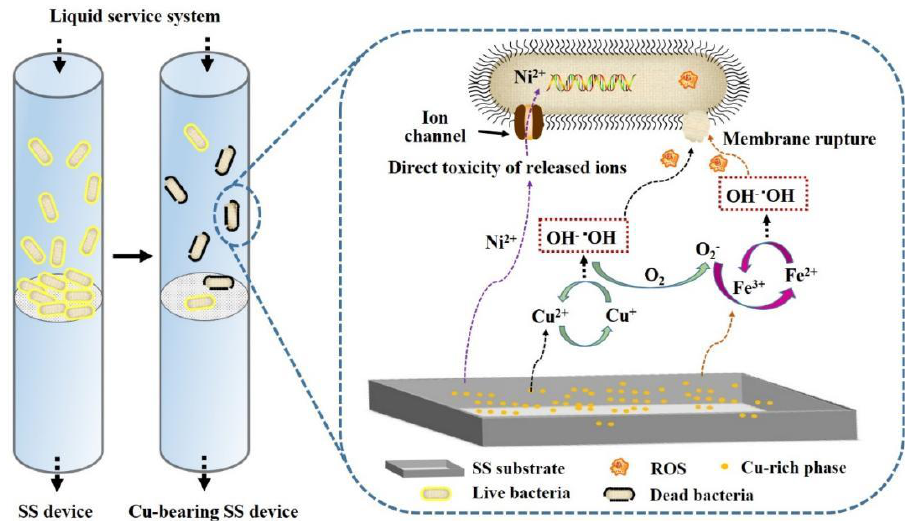
Figure 5. Release-type mechanism of Cu-bearing stainless steel in liquid system [77].